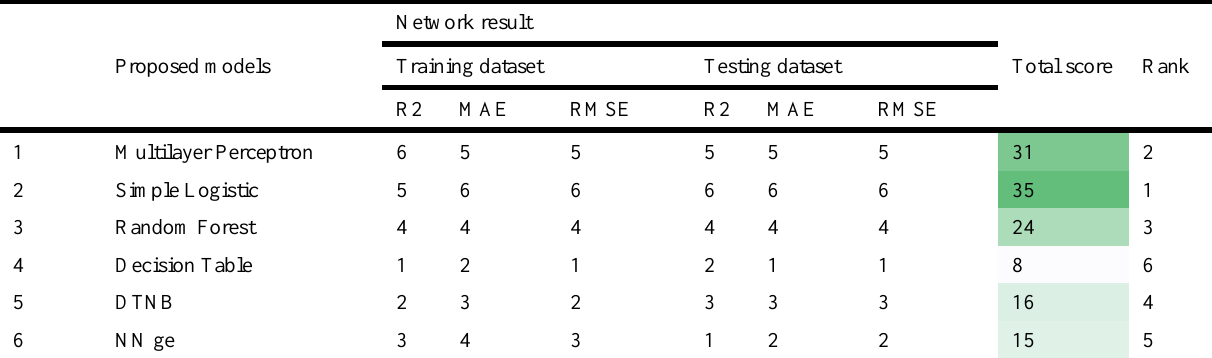
Table 4: Total ranking score and ranking of the proposed classification models based on the both training and testing